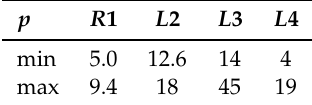
Table 1. Bounds of design variables for TEAM problem 25.